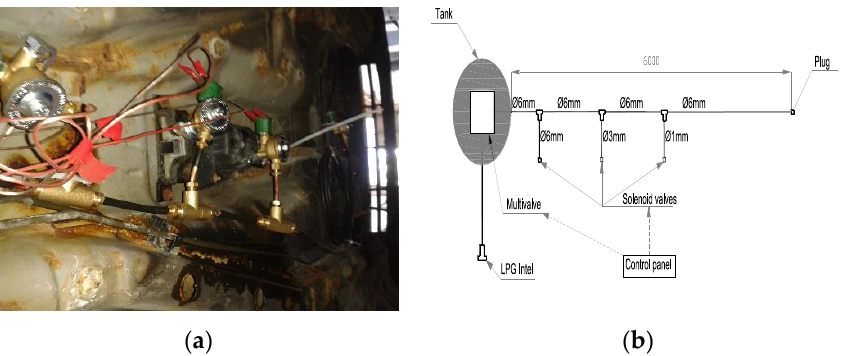
Figure 10. Photo ( a ) and scheme ( b ) of the car installation used during the LPG dispersion experiment.